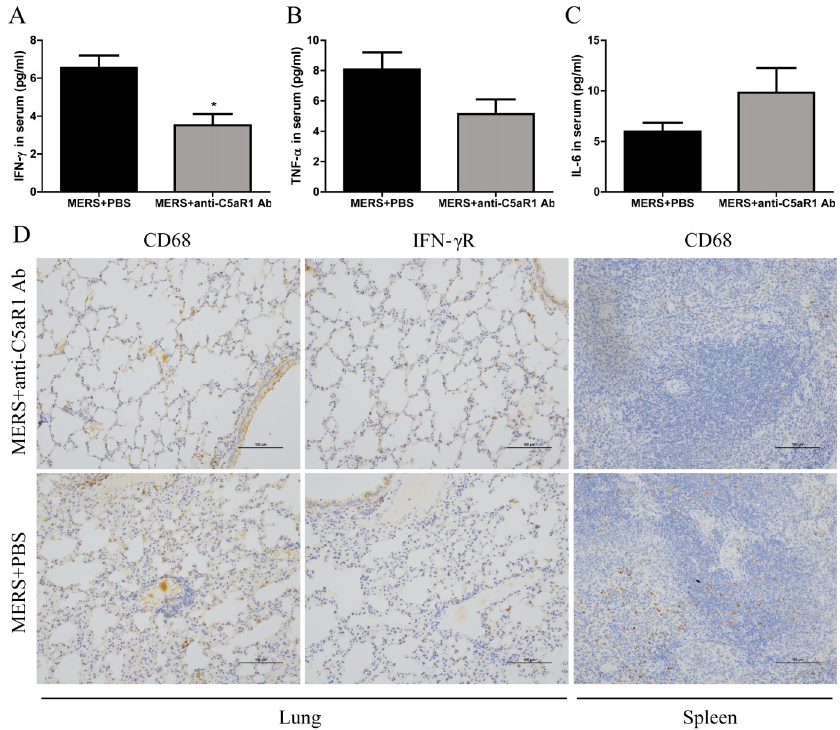
Figure 6. Blockade of the C5a-C5aR1 axis reduces pyroptosis in hDPP4-transgenic mice. ( A – C